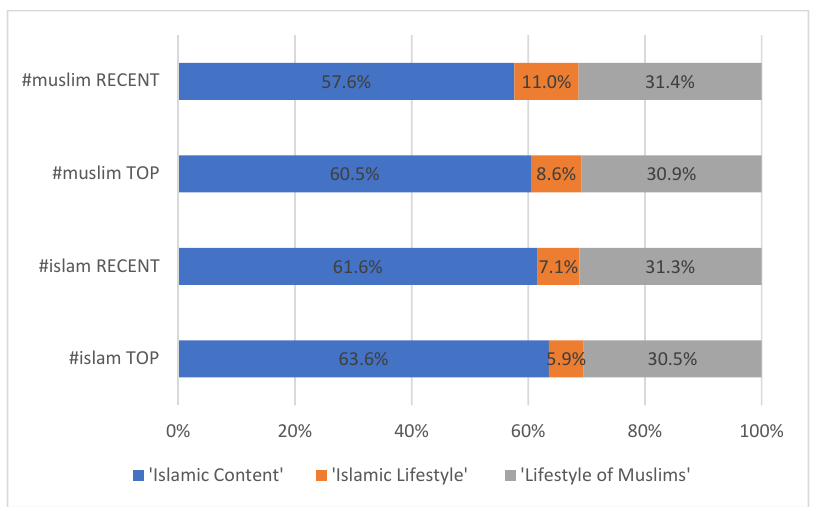
Figure 1. Distribution of content, depending on the hashtag (#muslim or #islam) and the filtering method (“recent” and “top”).